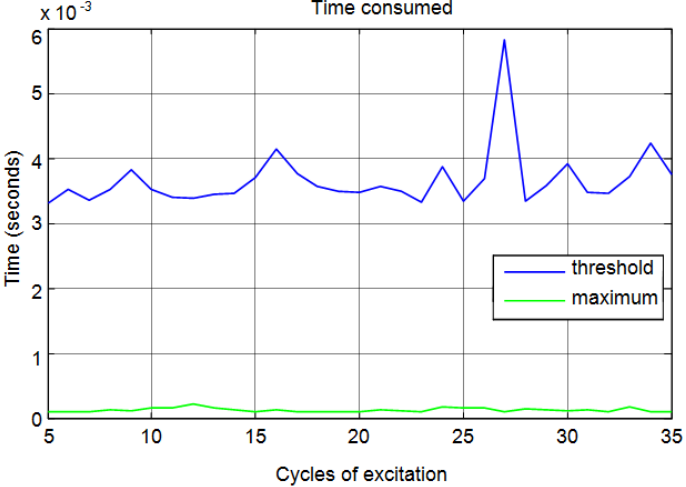
Figure 19. Computation time for the calculation of distances for threshold and maximum